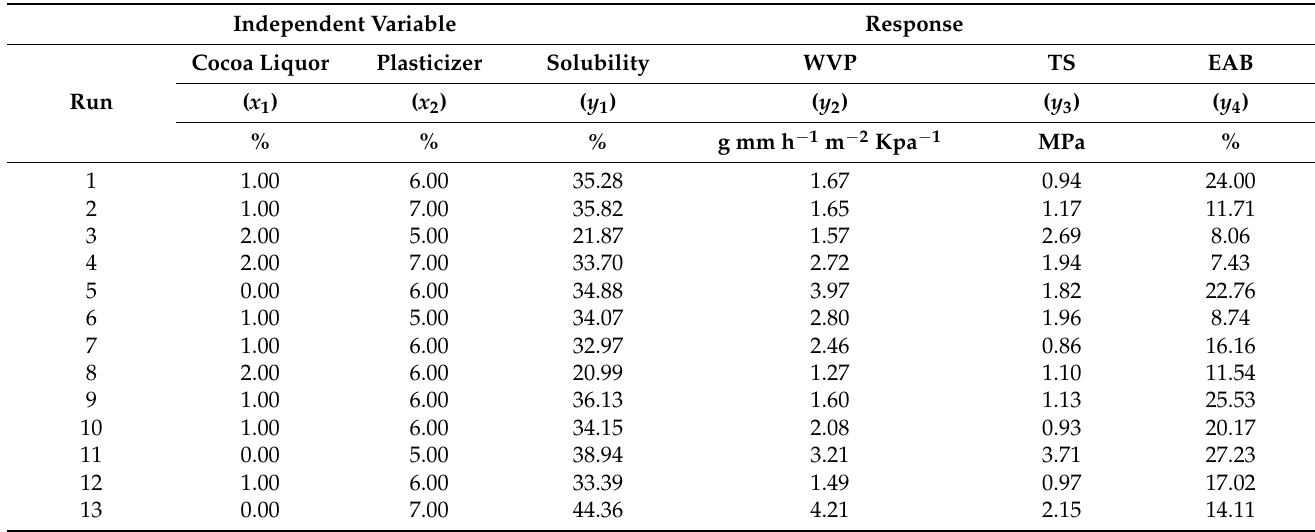
x : represents the independent variables plotted on the x -axis; y : represents the response plotted on the y -axis. Response is the mean value of three replicates. WPV: Water Vapor Permeability; TS: Tensile Strength; EAB: Elongation At